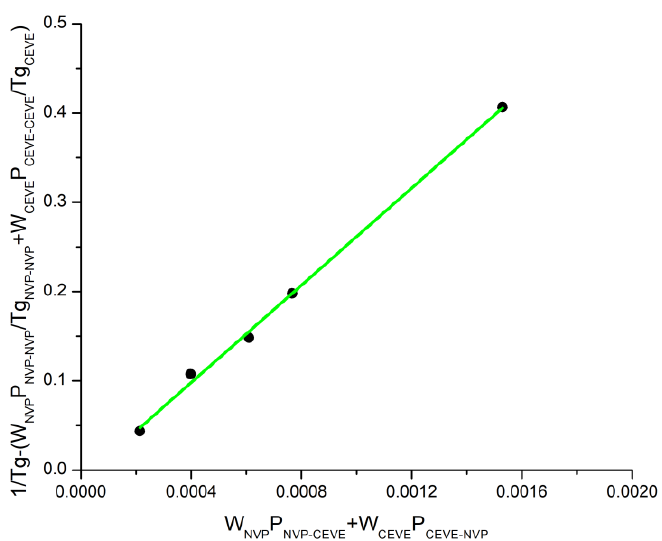
Figure 4. Plot of the linearized form of the Barton equation.